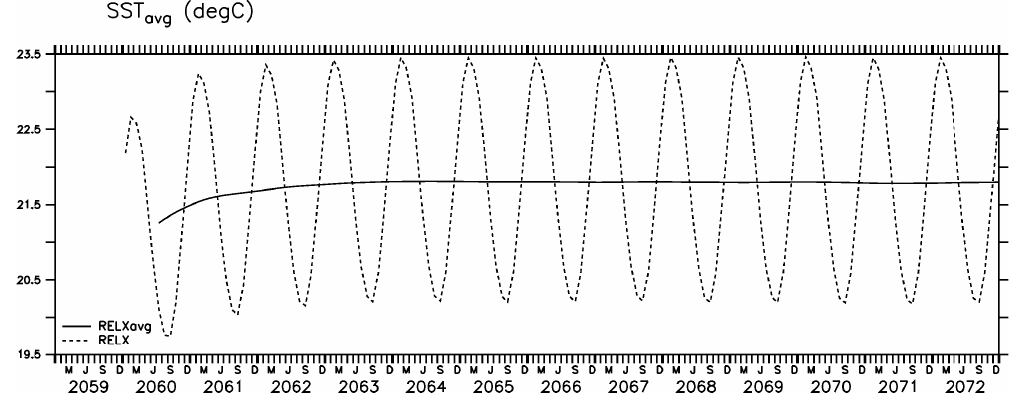
Fig. 5. Time series of monthly SST averaged over the region of interest for the RELX ODM projection. Also shown is the same SST smoothed with a 12-month filter.